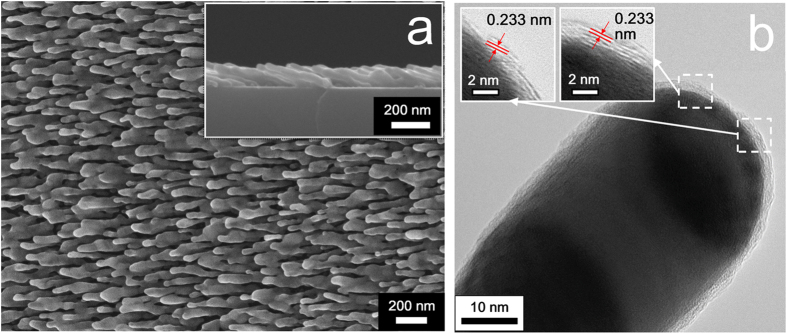
(a) Top-view and side-view SEM images of Ag@TiO2-3 NRs. (b) HRTEM images of a Ag@TiO2-3 NR after annealing at 300 °C.